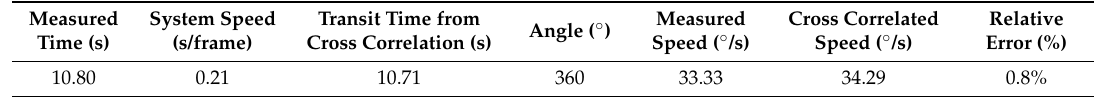
Table 2. Calculated results of the 2D experiment.